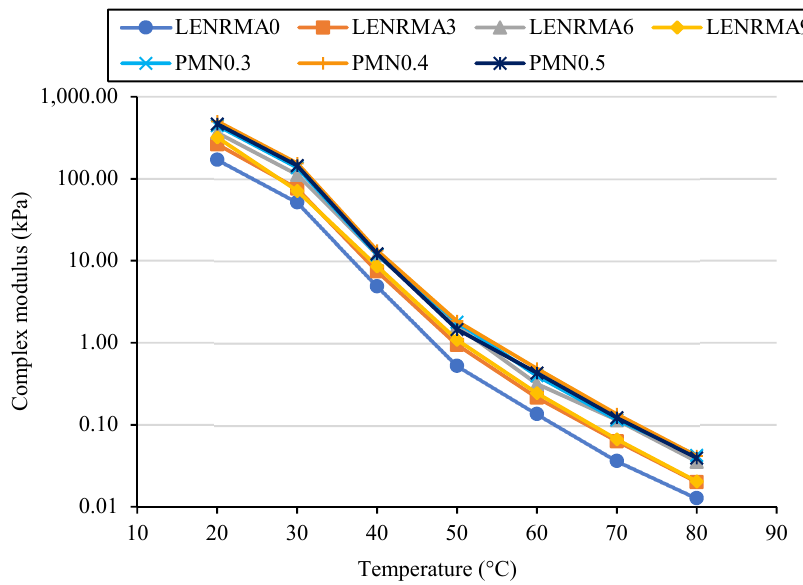
Figure 10. Complex modulus versus temperature at 0.1 Hz of binders (isochronal plots).